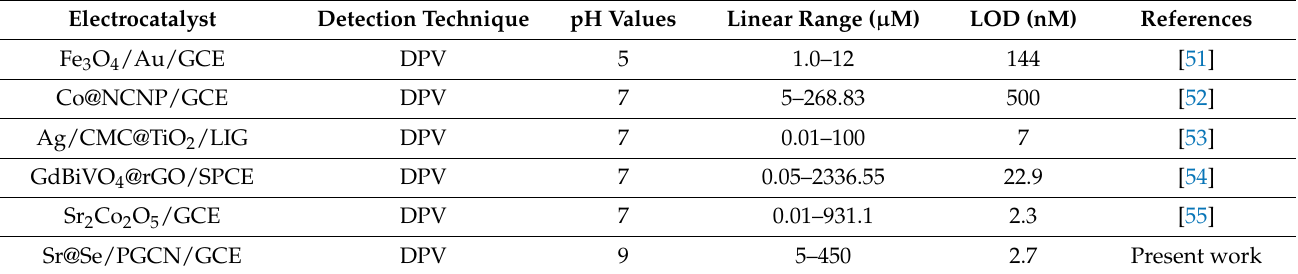
Table 1. Electroanalytical characteristics of Sr@Se/PGCN/GCE and other electrocatalysts.